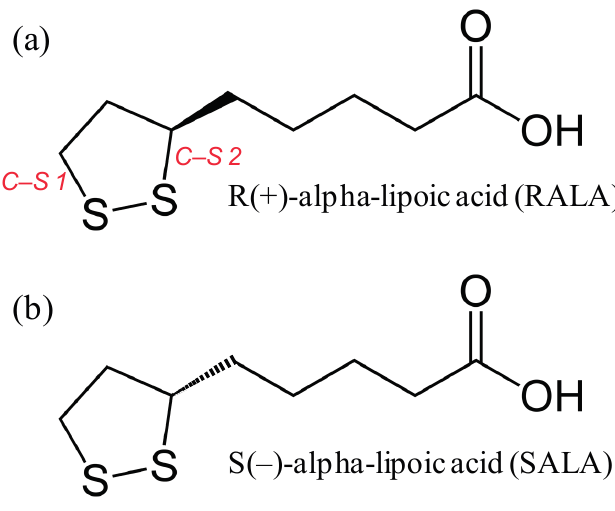
Figure 2. Chemical structures of ( a ) R (+)-ALA (RALA); and ( b ) S ( − )-ALA